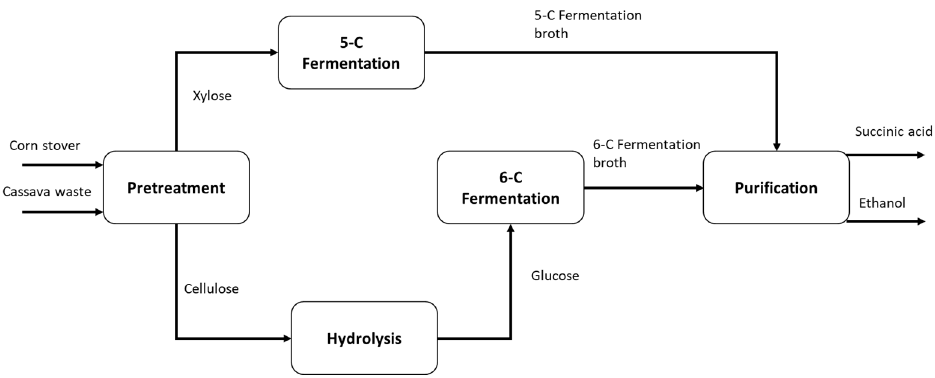
Figure 6. Hierarchized layout for succinic acid and ethanol production.